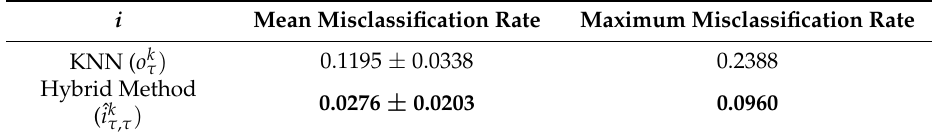
Table 6. Classification performance of the KNN classifier and the proposed hybrid method.